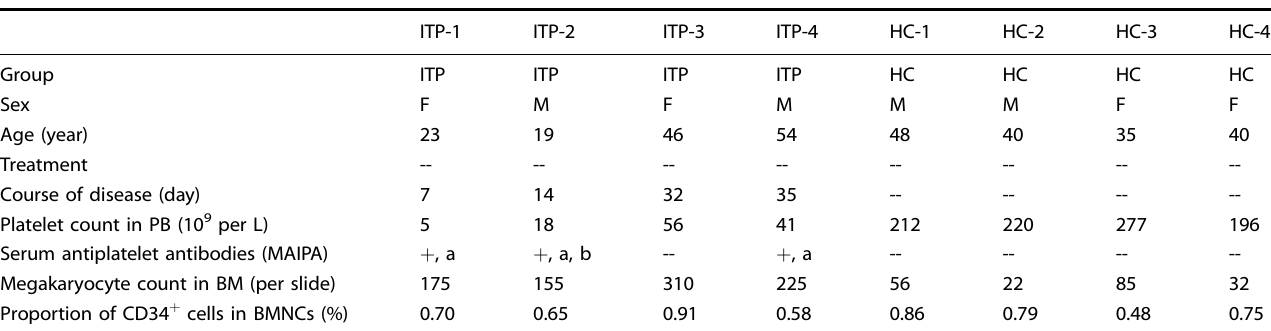
Table 1. Baseline characteristics of participants enrolled for